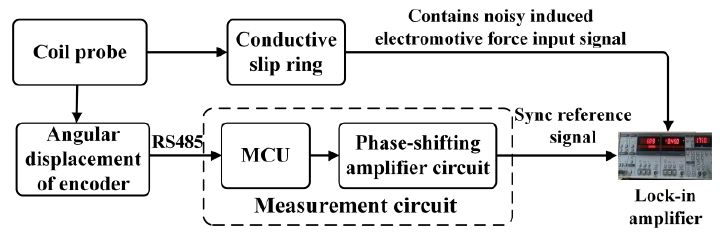
Figure 4. Signal processing flow.